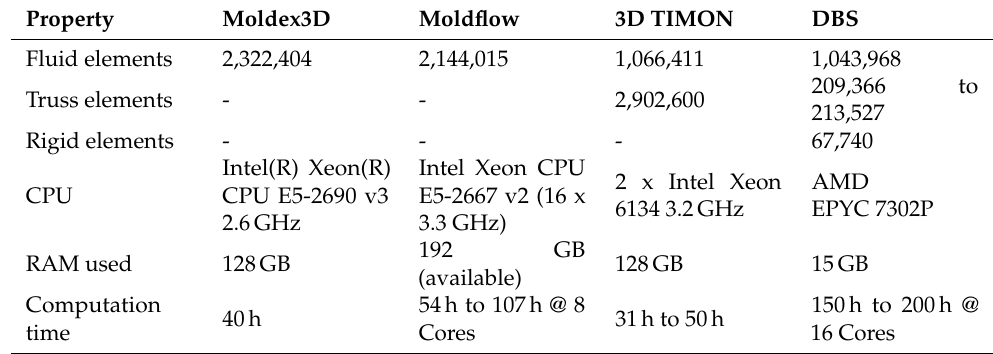
Table A6. Computational